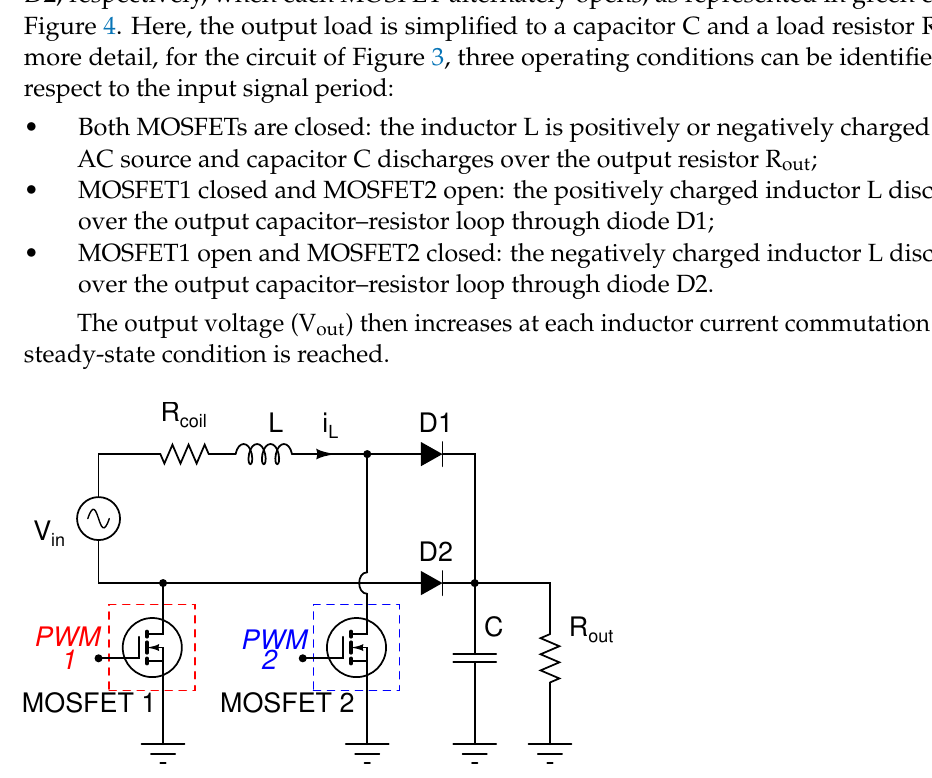
Figure 3. Electrical schematic of the proposed AC–DC boost